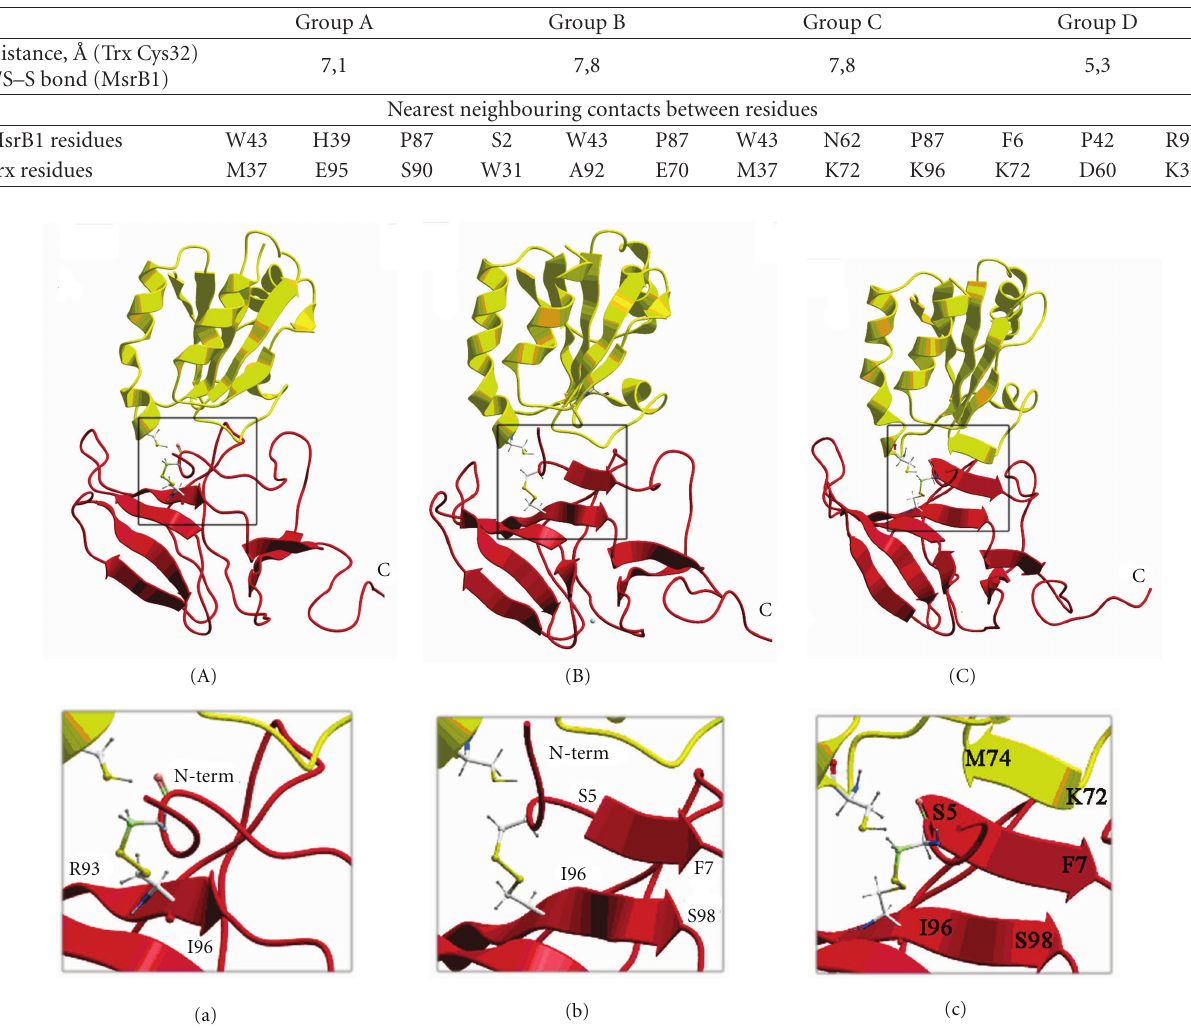
Figure 3: The snapshots (A, B, and C) of the protein complex formation along the molecular dynamics trajectory. The panels (a), (b), and (c) show zoomed views (interactions interfaces) of the snapshots (A) and (C),